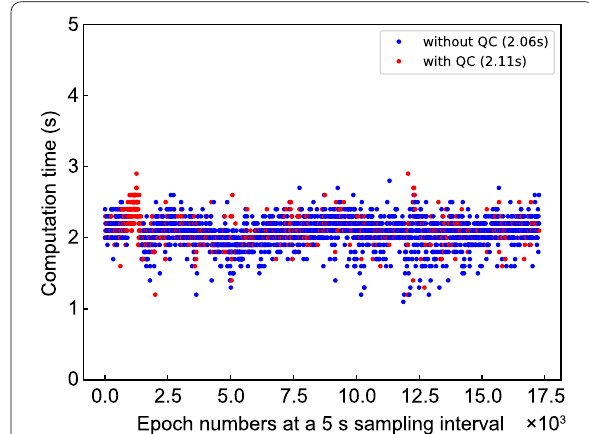
Fig. 4 The epoch-wise computation time for clock estimation with and without quality control on 8 June